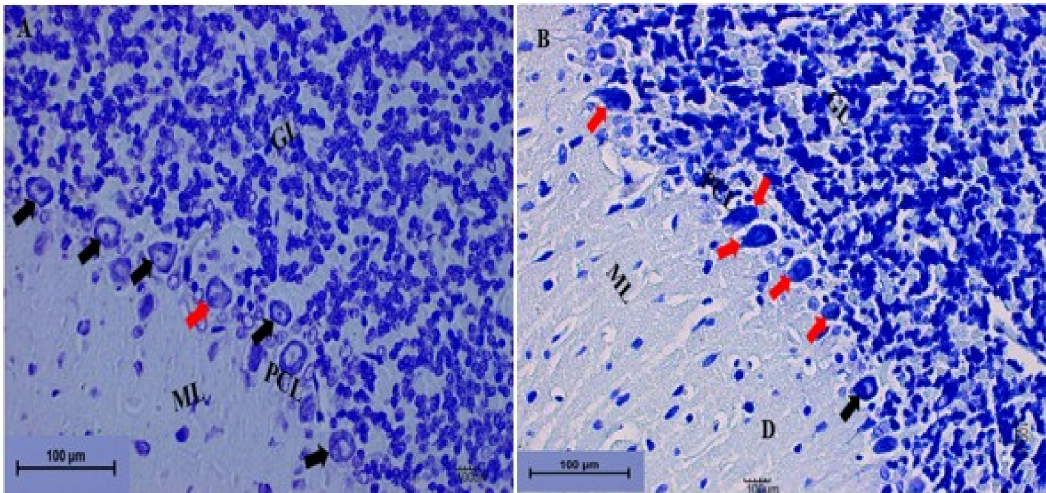
Figure 8. Photomicrograph sections of the cerebellums from the rat groups. ( A ) Control showing the molecular layer (ML), the granular layer (GL), and the Purkinje cell layer (PCL). The Purkinje cells are shown by the black arrow, with prominent nuclei. ( B ) LTG showing the molecular layer (ML) with a degenerated area of cells (D) and Purkinje cells with darkly stained cytoplasm and distorted nuclei leaving spaces between them (red arrow). The granular layer (GL) indicates deeply stained cells with vacuolation (toluidine blue 200 × , scale bar = 100 µ m).